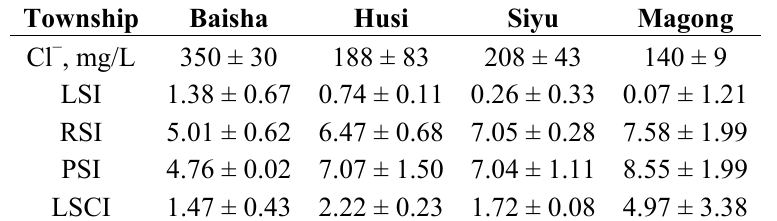
Table 3. Assessment of scaling and corrosion tendency-tap-water quality in Penghu County [13].